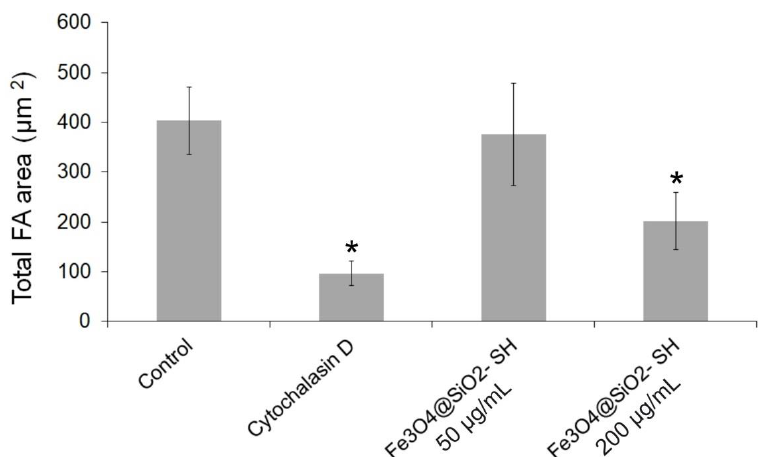
Figure 10. Histogram representing the cellular focal adhesion (FA) areas of control cells or cells treated with Fe 3 O 4 @SiO 2 -SH nanoparticles at 50 and 200 µg/mL. Values are represented as the mean ± SD ( n = 10). * — significantly different to control ( P ≤ 0.05). Cells treated with cytochalasin D (0.5 μg/mL) were used as a positive control.